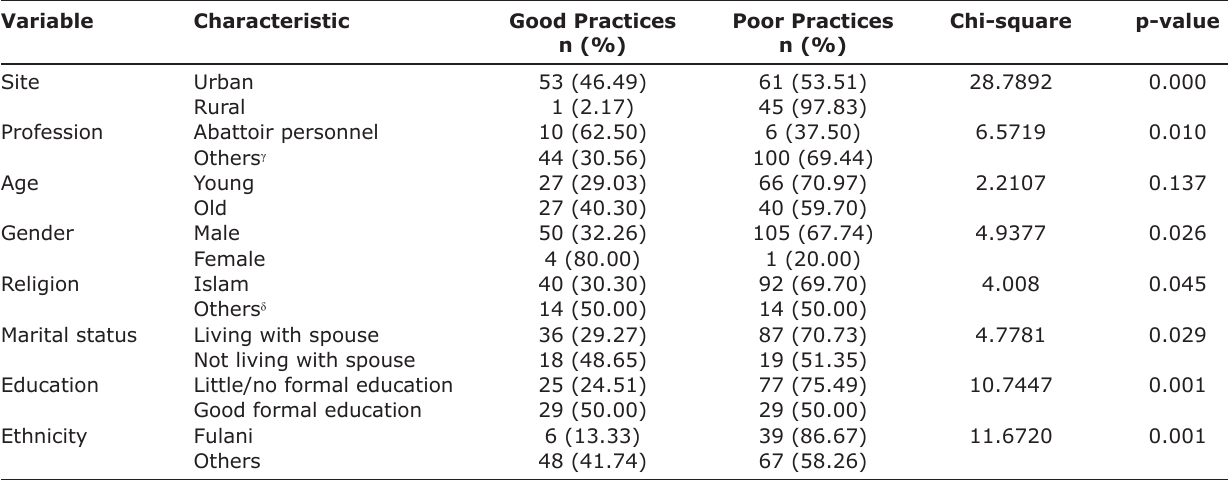
Table-4: Factors associated with practices that could aid exposure to Brucella infection among high-risk persons in Lafia, Nasarawa State (n=160) Variable